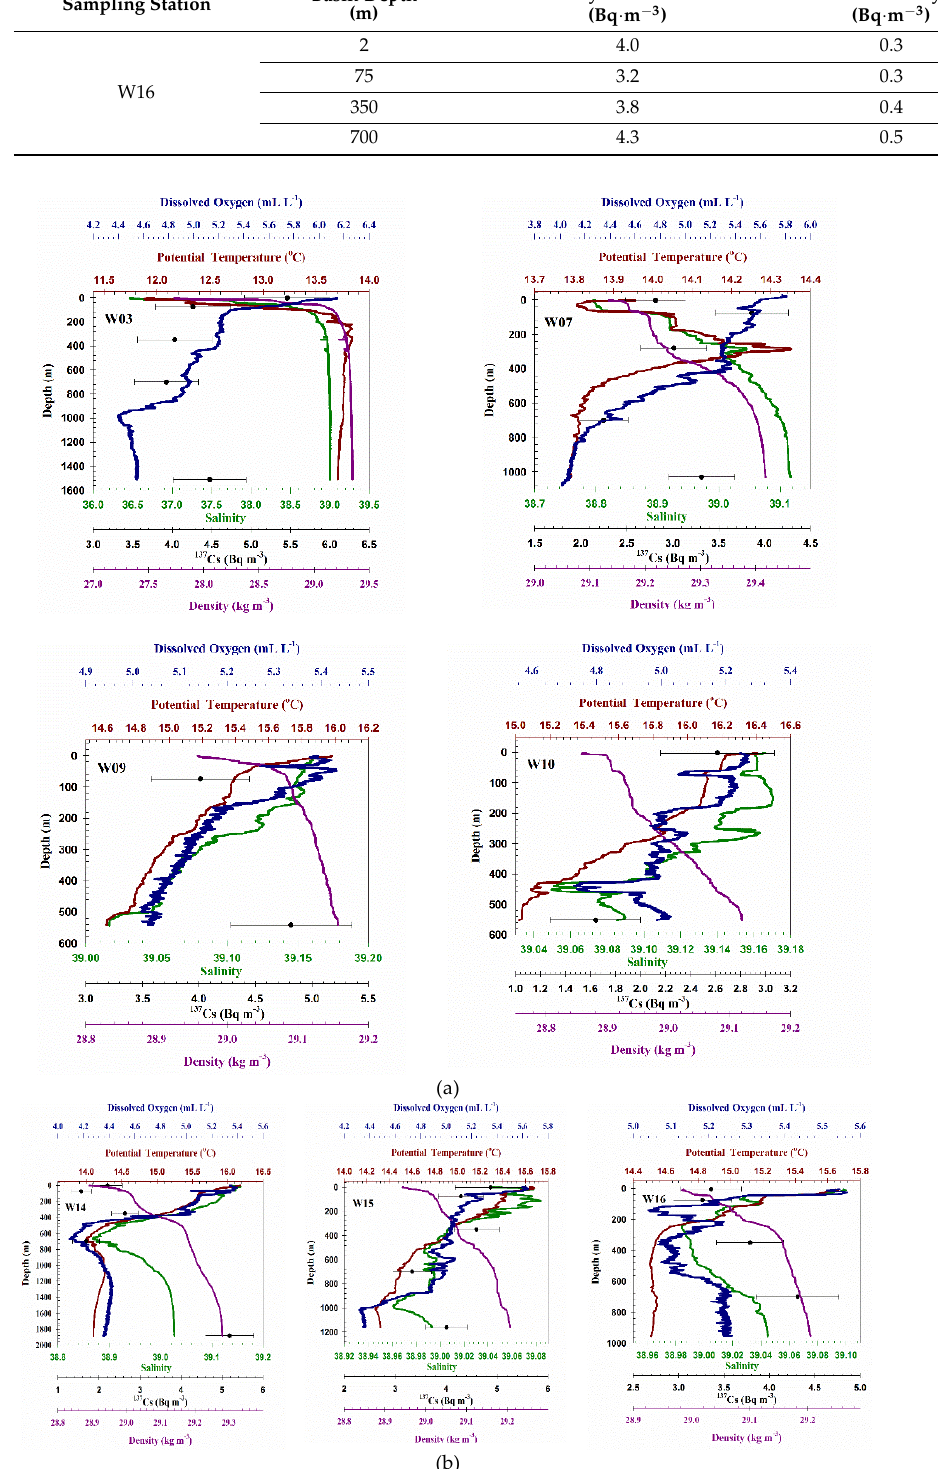
Figure 2. Vertical profiles of 137 Cs activity concentrations in water column along with casting records of oceanographic parameters (potential temperature, salinity, density and dissolved oxygen) at deep basins of ( a ) the North and Central Aegean; and ( b ) the Cretan and Myrtoan Seas.